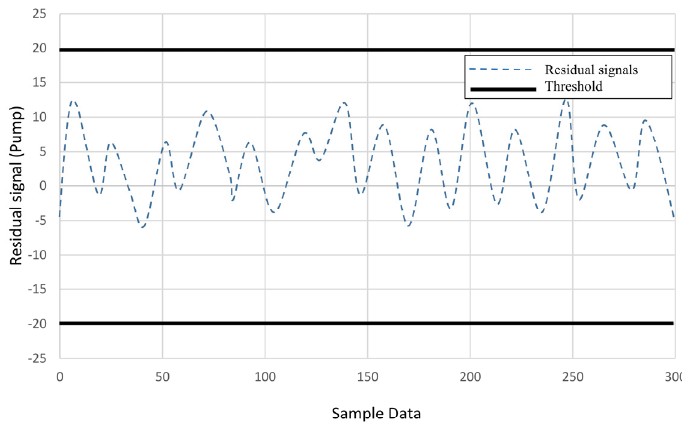
Figure 4. The pump signal for the pipe under no-fault